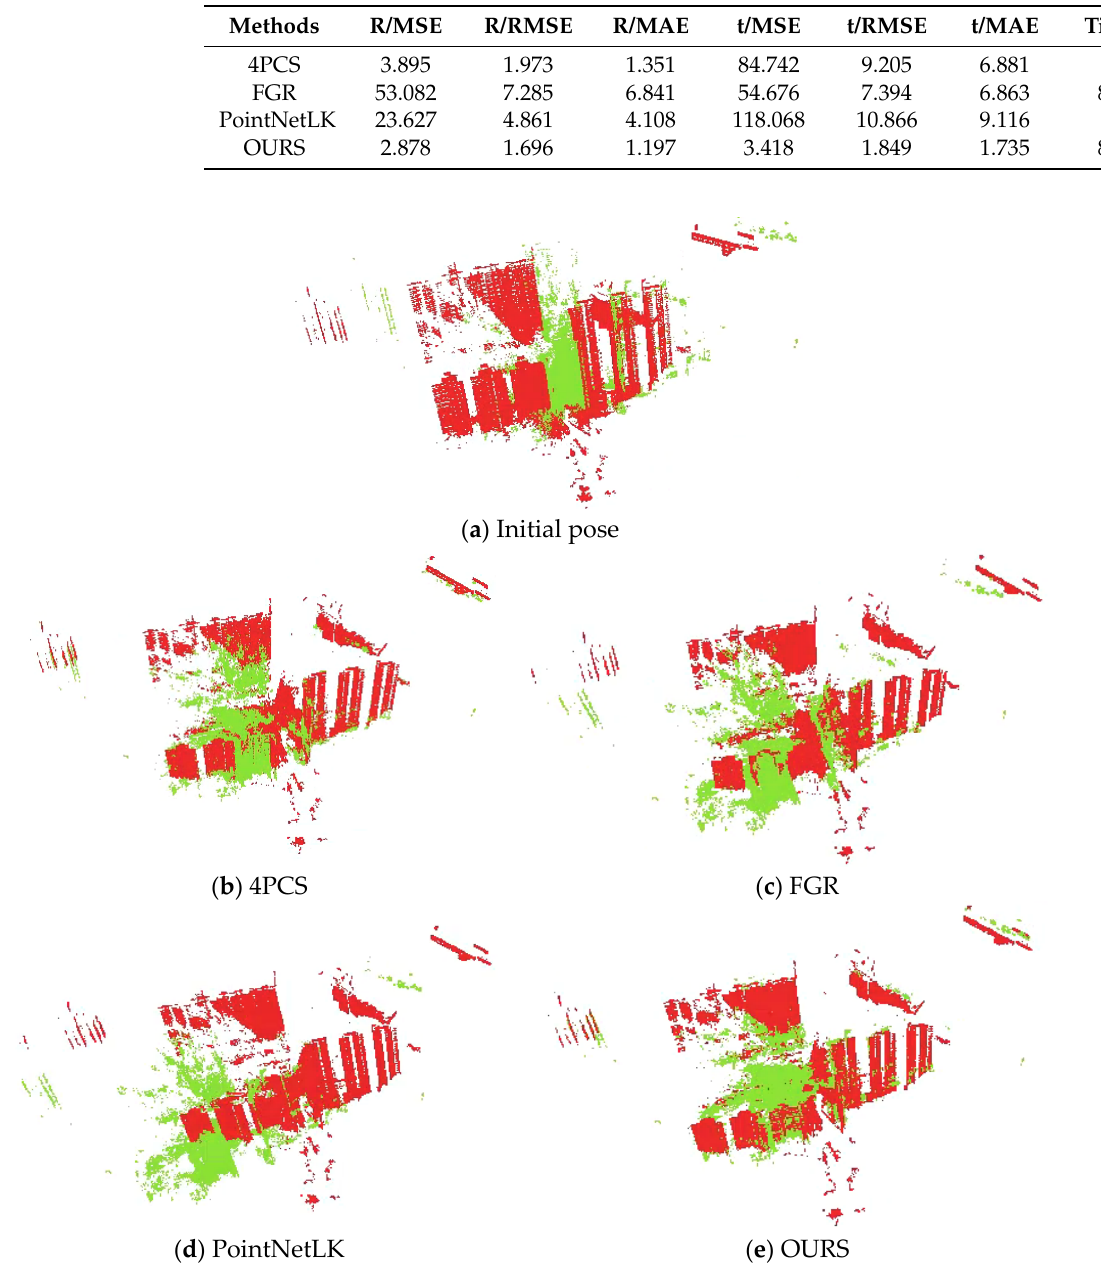
Figure 6. Registration results of each algorithm for residence scenes.